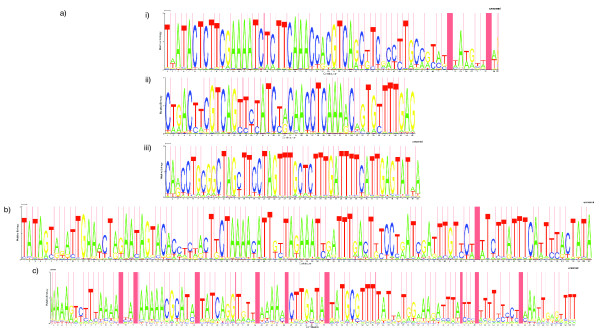
HMM logos representing pneumococcal interspersed repeat sequences. These images describe the HMMs used for sequence searches. Each column corresponds to a nucleotide in the repeat element. The total height of bases in each column represents how informative that position is in describing the element; the relative heights of the different bases indicate their respective emission probabilities in the model. Red shaded columns show positions where base insertions occur: the total width of these columns represents the expected number of inserted bases, whilst the dark shaded component indicates the probability that an insertion occurs. The repeats displayed are a) i) boxA, ii) boxB, iii) boxC, b) RUP and c) SPRITE.